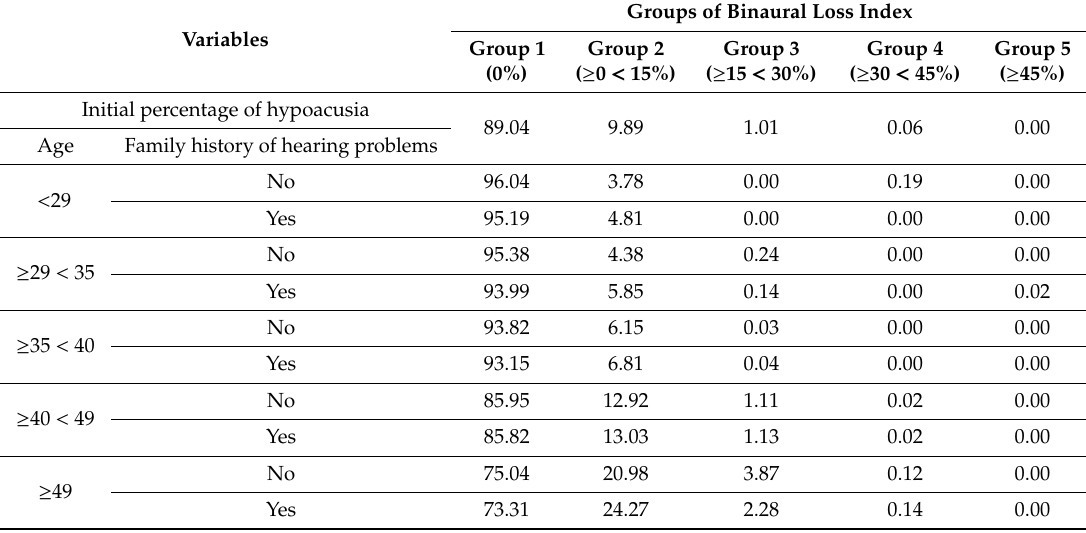
Table 7. Sensitivity analysis. Age and family history of hearing problems vs. Binaural Percentage Index. Source: Compiled by